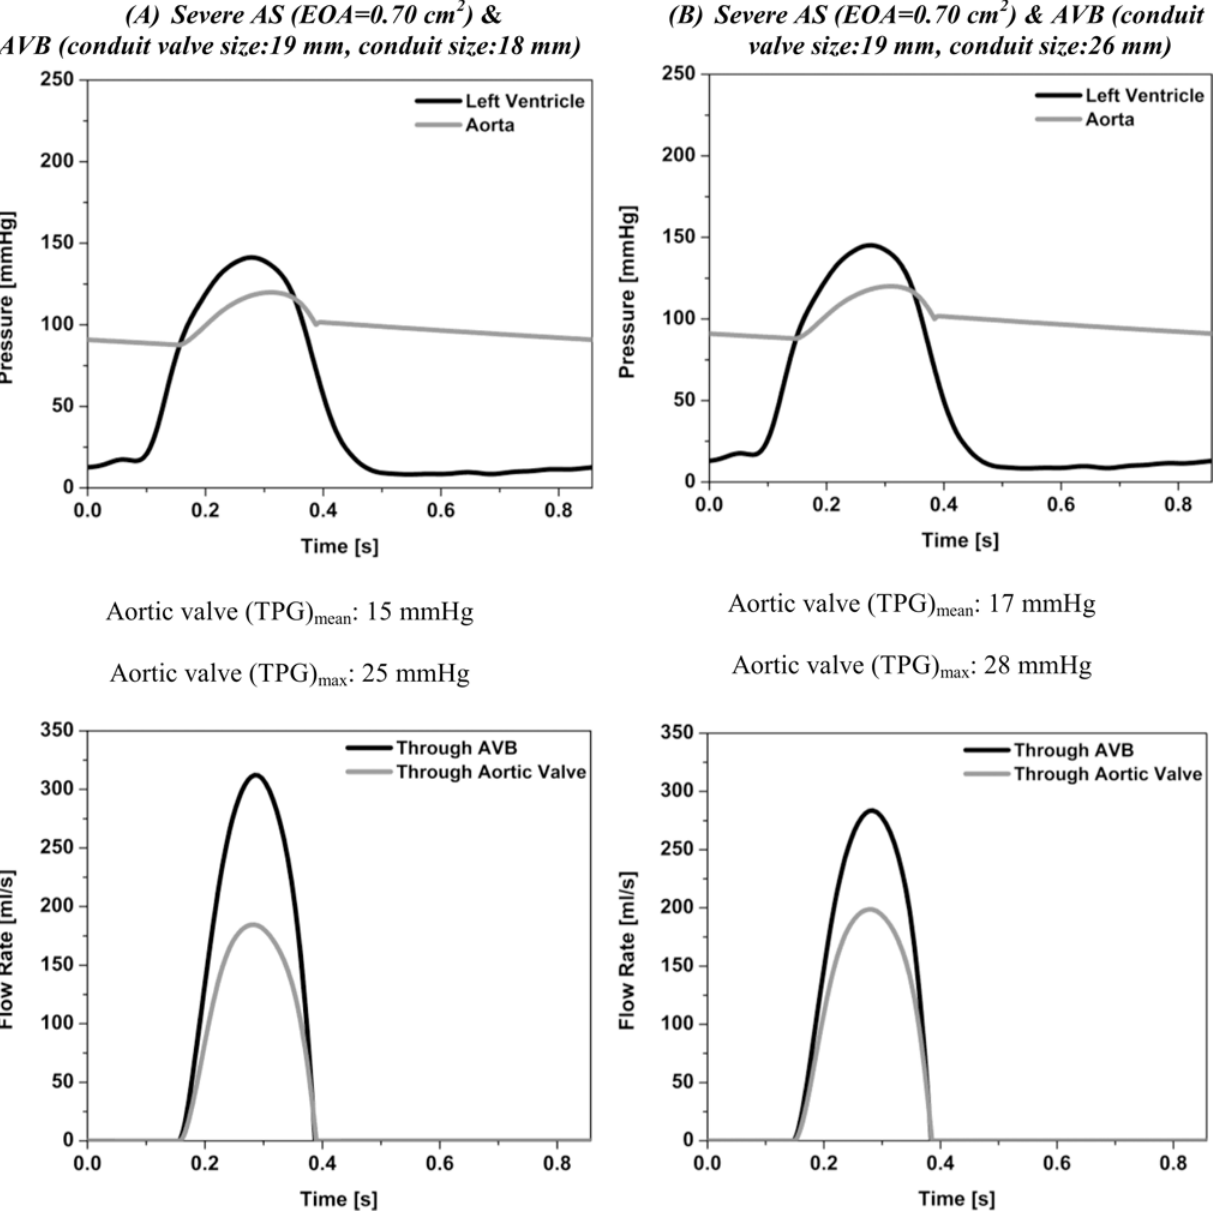
Fig 3. Simulated left ventricle and aorta pressures and flow distribution. (A) Severe AS (EOA = 0.7 cm 2 ) & AVB (conduit valve size: 19 mm, conduit size: 18mm), (B) severe AS (EOA = 0.7 cm 2 ) & AVB (conduit valve size: 19 mm, conduit size: 26mm). Stroke volume, heart rate and cardiac output are 75 ml, 70 beats/min and 5.2 l/min,